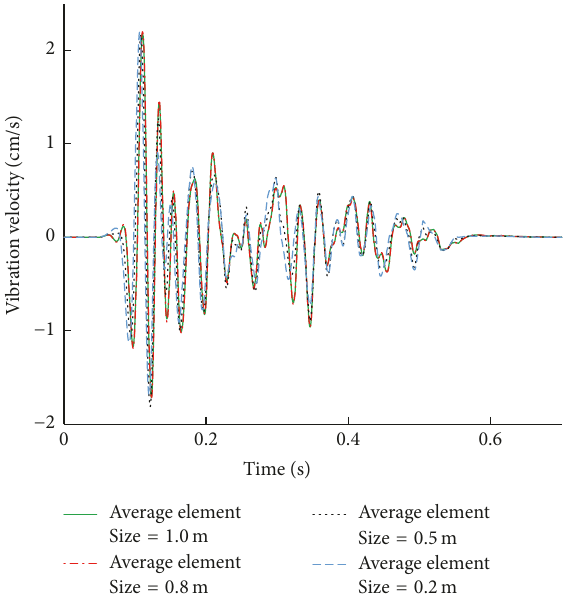
Figure 8: Waveforms calculated with different element sizes.